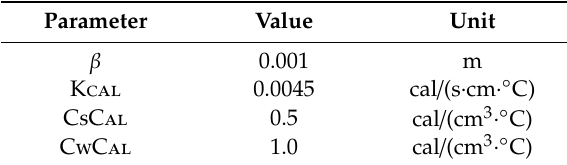
Table 2. Input parameters of VFLUX2 code. β is dispersivity, K cal thermal conductivity, C s C al and C w C al volumetric heat capacity of sediment and water,